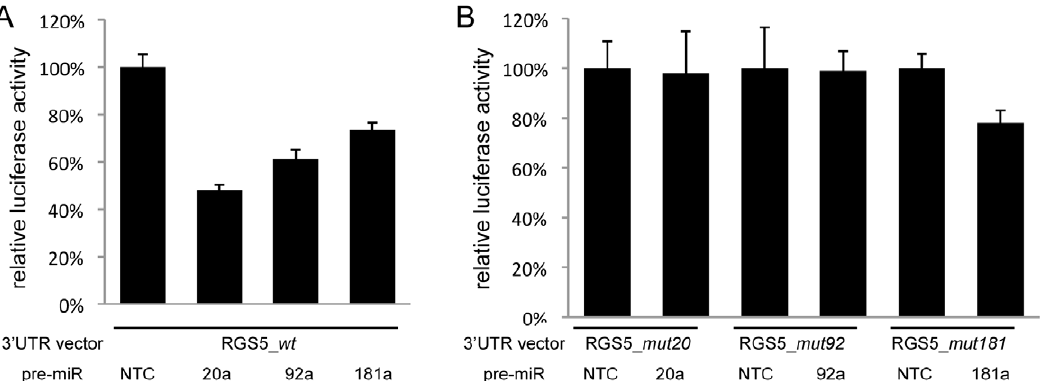
Figure 2. miRNA interaction with the 3 9 UTR of RGS5. A. Relative luciferase activity obtained by transfecting cells with the wild type 3 9 UTR of RGS5 in combination with pre-miR-negative control (NTC), pre-miR-20a, pre-miR-92a and pre-miR-181a in HEK293T cells. B. Relative luciferase activity obtained by transfecting cells with mutated 3 9 UTR of RGS5 in combination with pre-miR-NTC, pre-miR-20a, pre-miR-92a and pre-miR-181a in HEK293T cells.